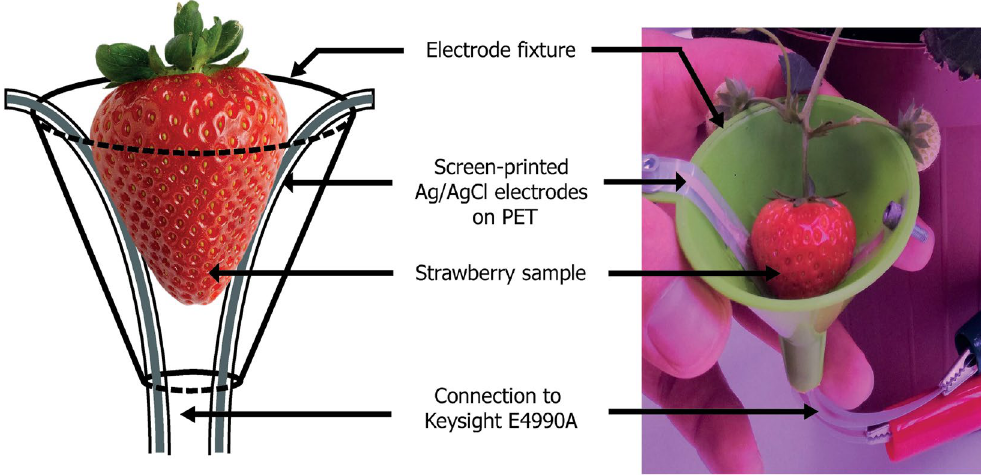
Figure 1. Measurement setup for the strawberry on-plant bioimpedance data acquisition, including the schematic (left) and the real application (right).